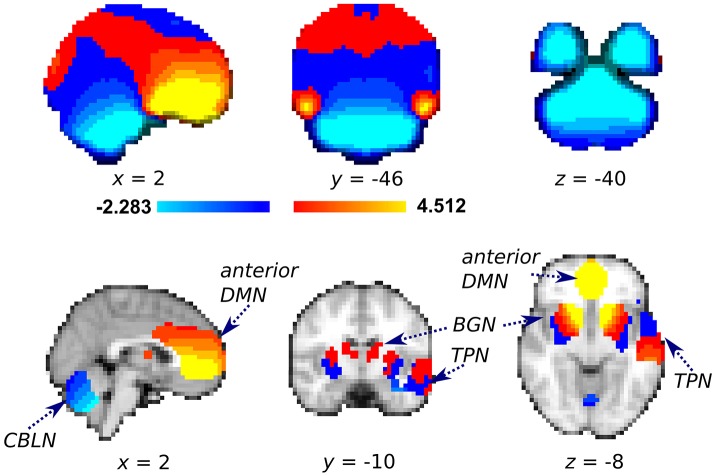
Averaged unwarping shift map of the whole brain (Top) used for field map correction and the same information restricted to the representative cluster of each independent component analysis of interest (bottom). Red-yellow color: voxels were shifted anterior–posterior (mm per voxel); Blue-light blue: voxels were shifted posterior–anterior. After successful distortion correction, voxels with positive and negative values should be shifted anterior–posterior and posterior–anterior, respectively. DMN, Default mode network; BGN, basal ganglia network; CBLN, cerebellum network; TPN, temporal pole network.